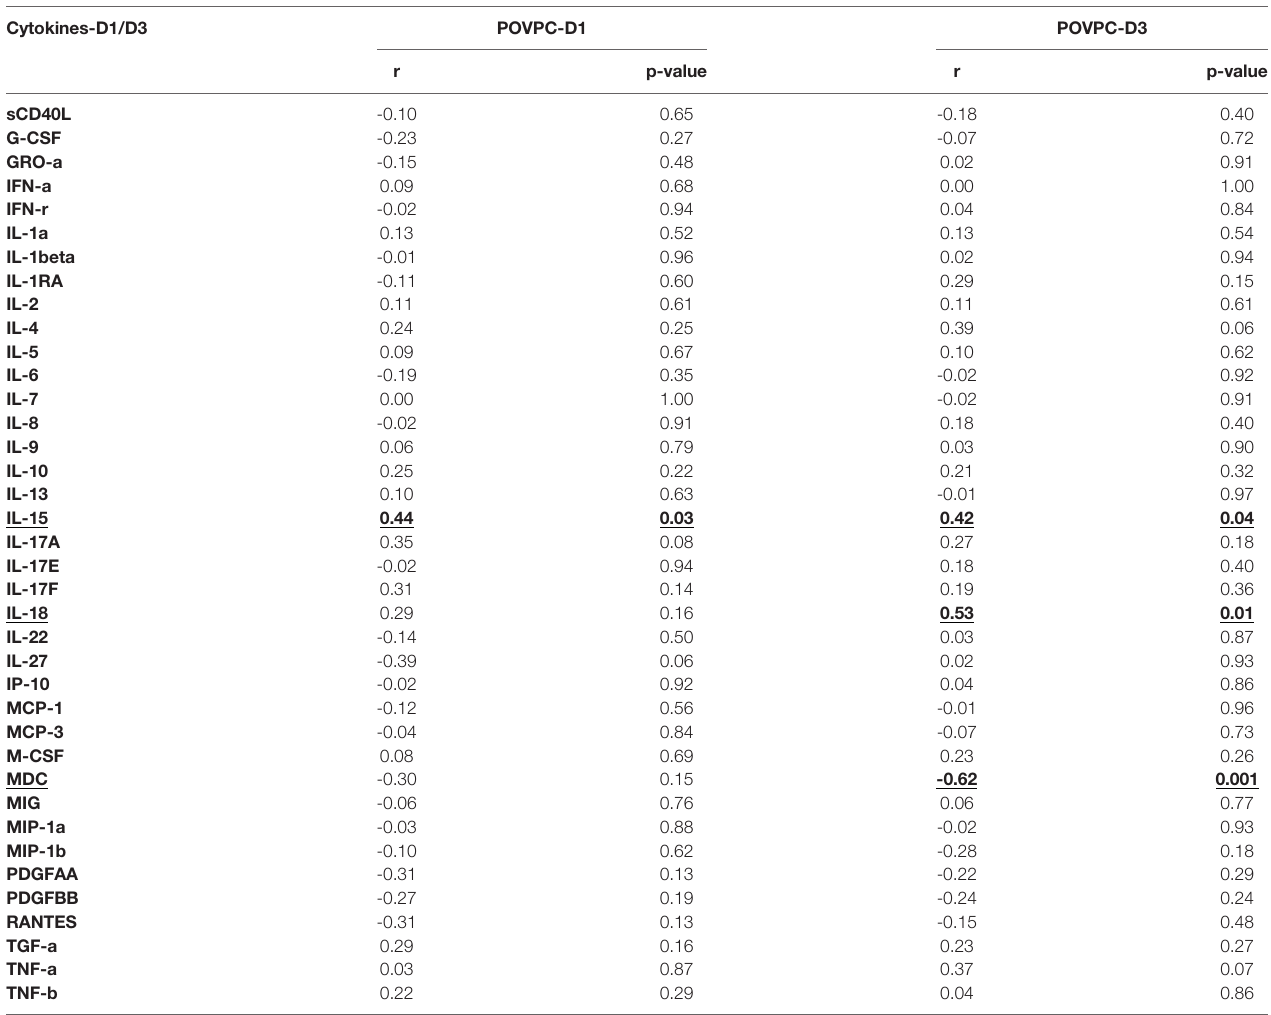
TABLE 4 | Correlation analysis between the level of POVPC in HDL and cytokines.